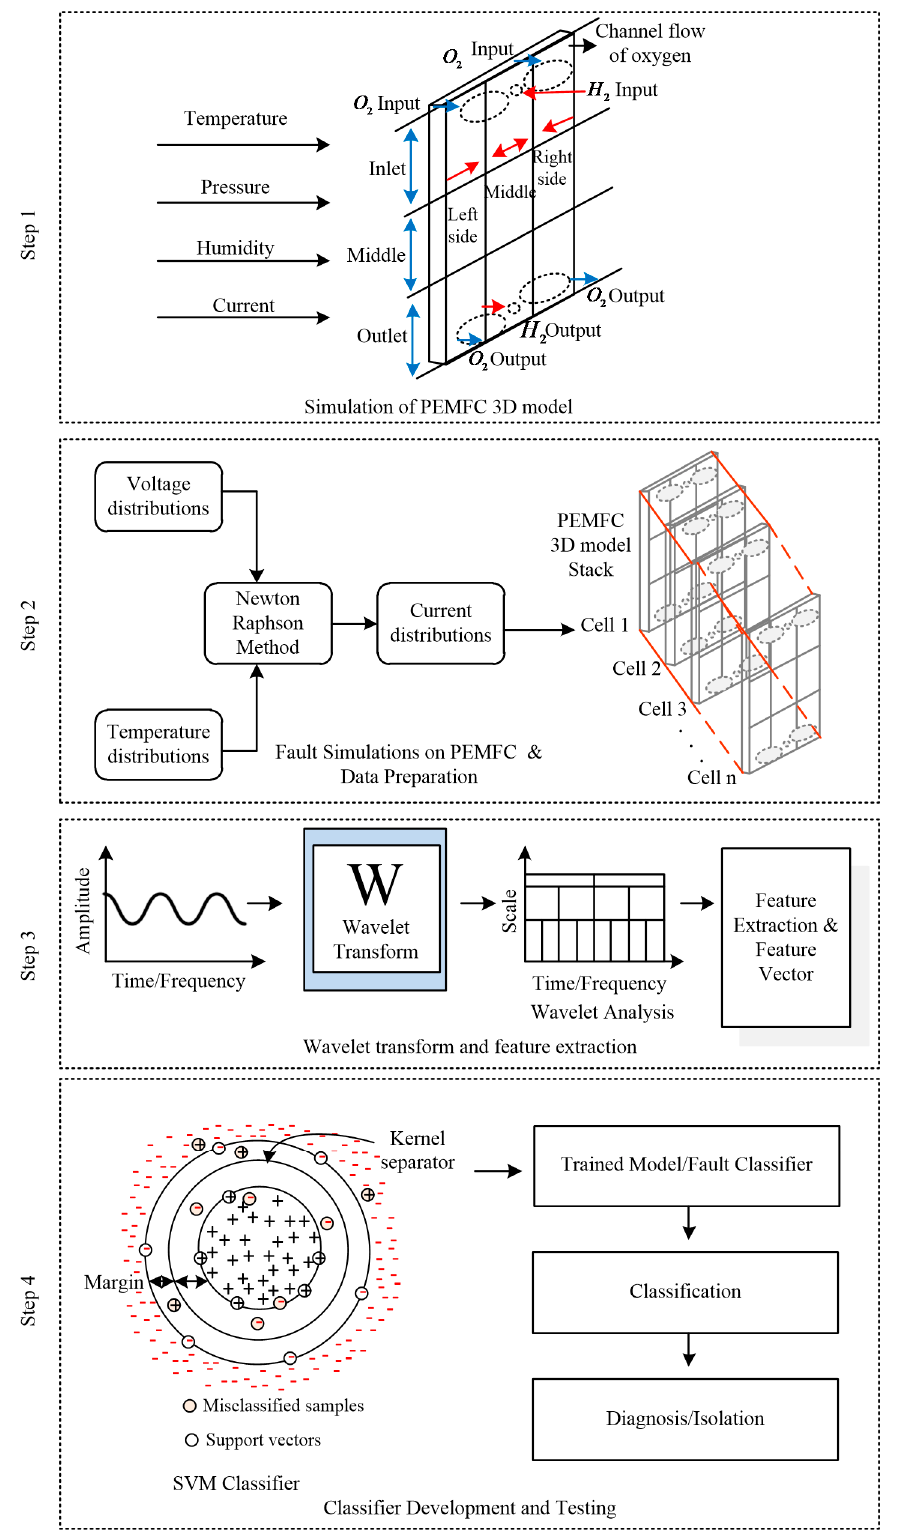
Figure 10. Layout of fault classification approach for PEMFC.